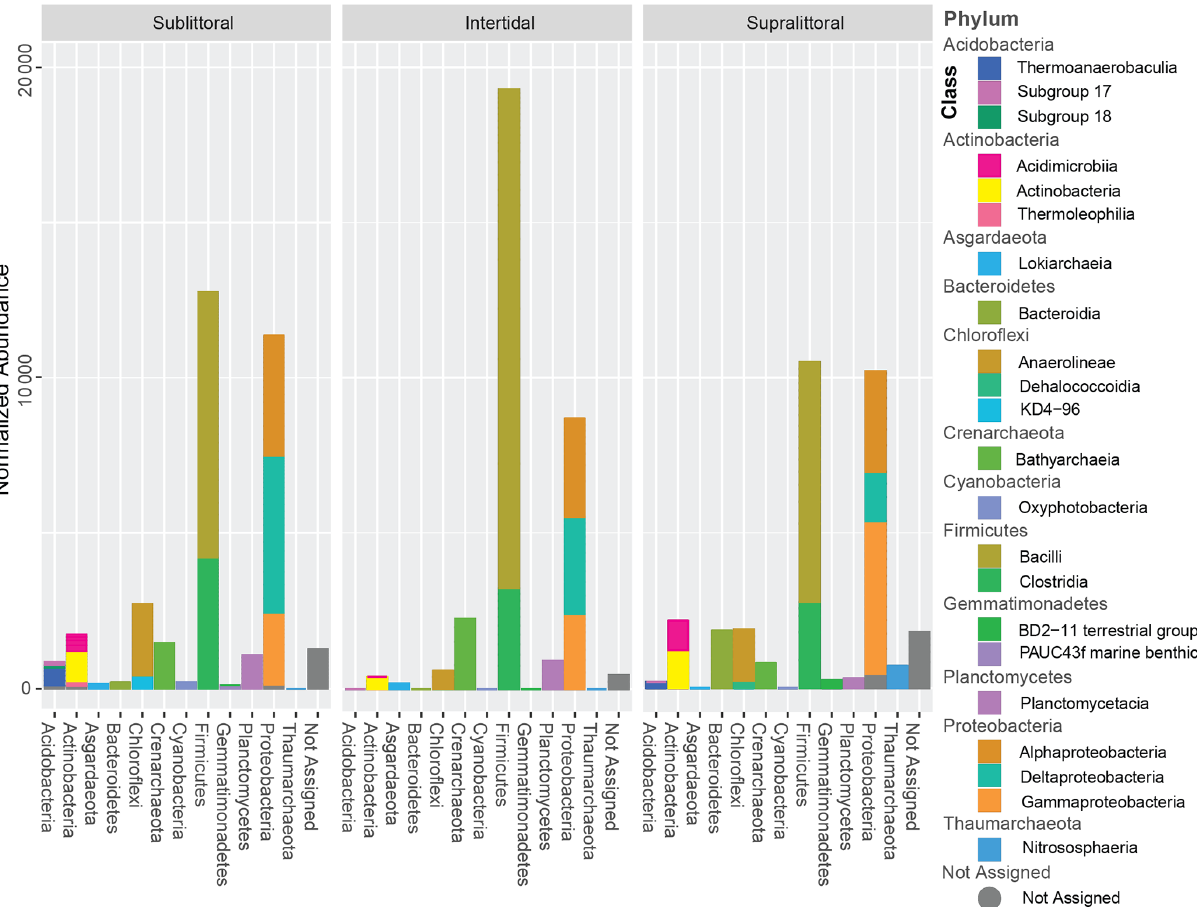
Figure 2. Normalized taxonomic abundances from each tidal zone. Taxa identified with an abundance higher than 1% are shown as stacked bar plots; the horizontal axis is the phylum level while the stacked bars are the class level. Taxa abundance has been normalized by down- sampling sequence